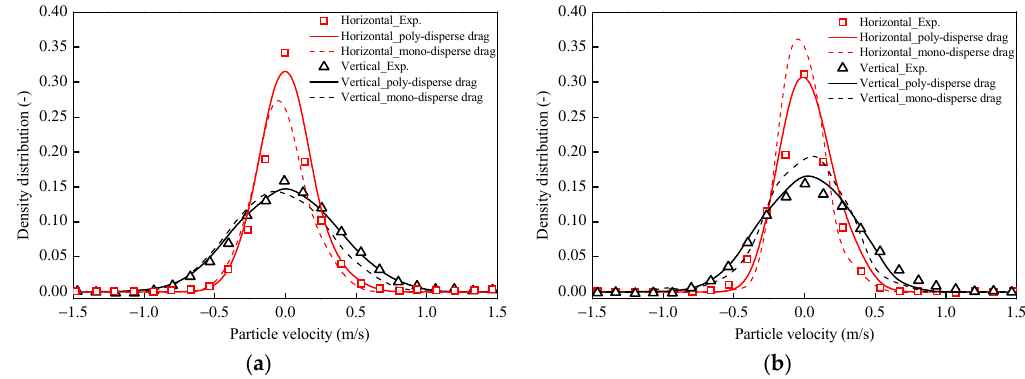
Figure 3. Density distributions of particle vertical velocity and horizontal velocity with different particle sizes: ( a ) particle P1; ( b ) particle P2.